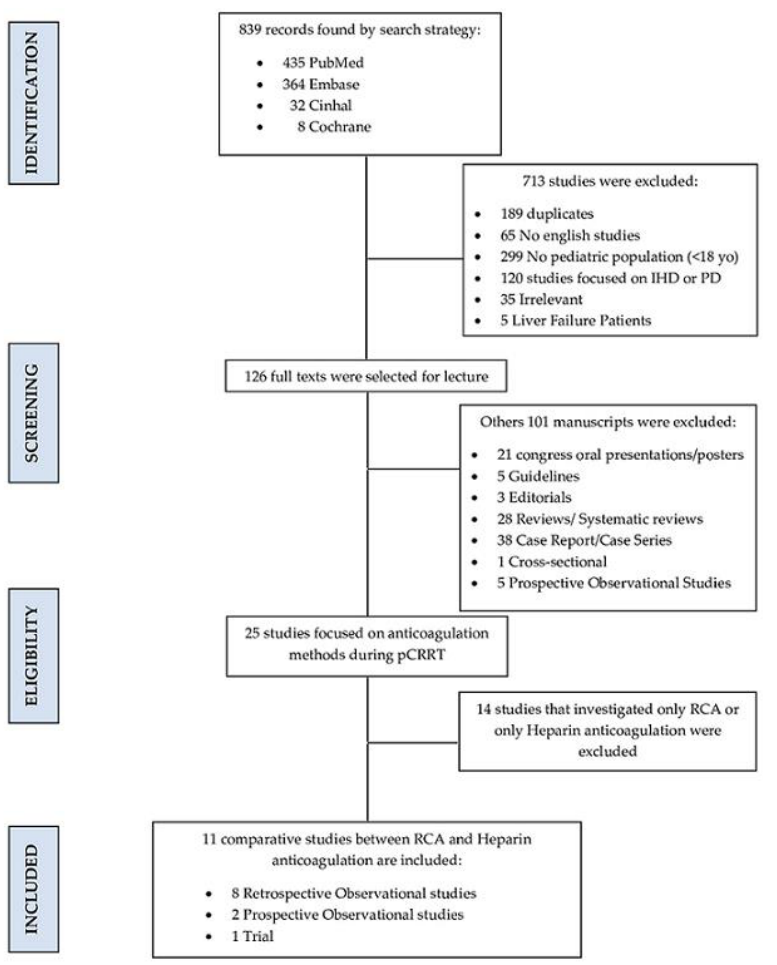
Figure 1. PRISMA flow chart. yo: years old; IHD: intermittent hemodialysis; PD: peritoneal dialysis; pCRRT: pediatric continuous renal replacement therapy; RCA: regional citrate anticoagulation.